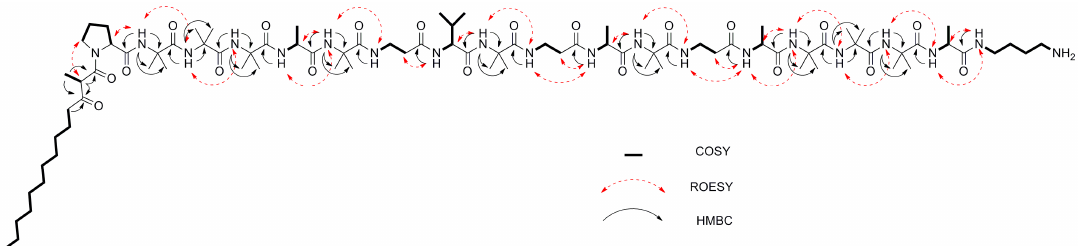
Figure 2. 2D NMR correlations used for structural characterization of compound 1.